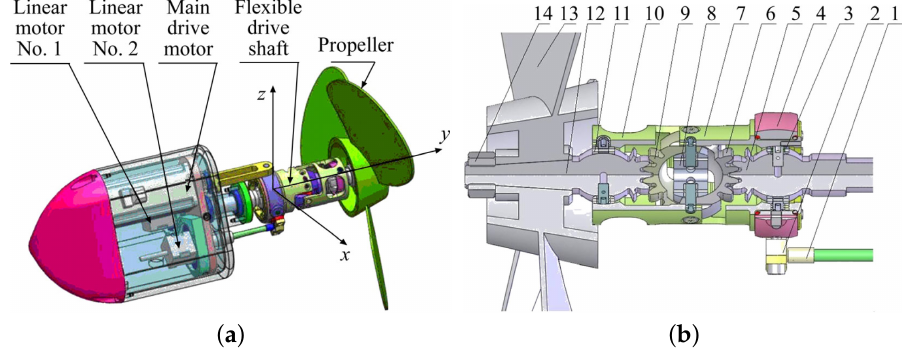
Figure 13. An RT with a wide reconfiguration [62]. ( a ) Thruster. ( b ) Ball gear